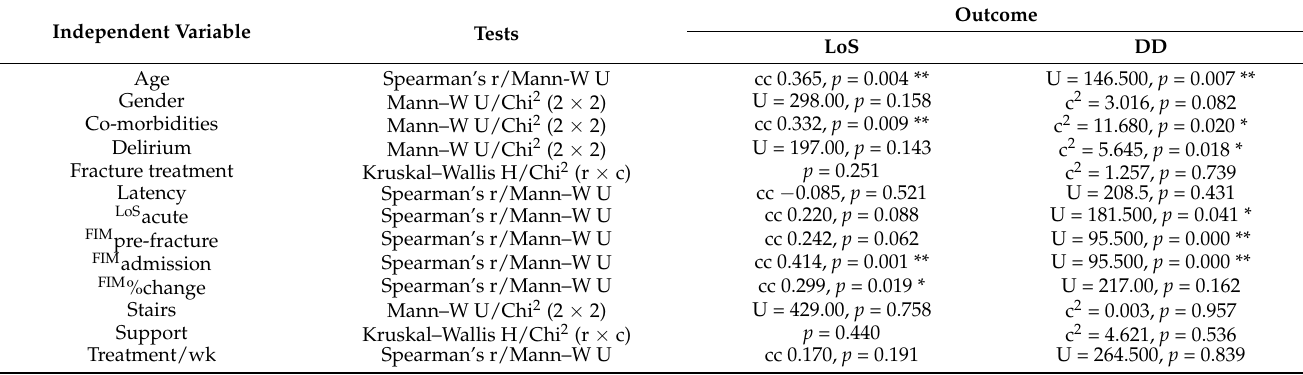
Table 2. Factors associated with length of stay and discharge